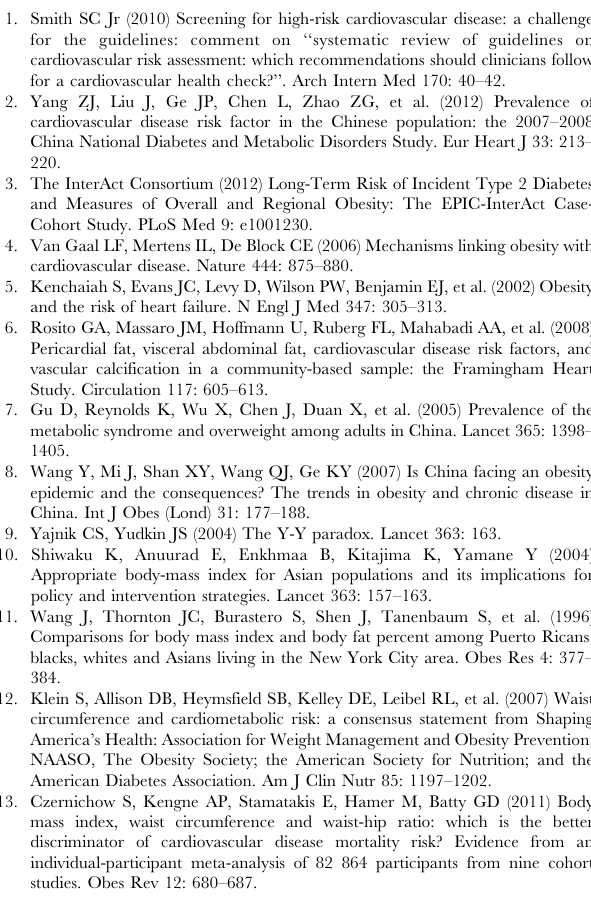
Table S2 The optimal cutoffs of combined WC and BMI categories in identifying CMD determined by ROC curve